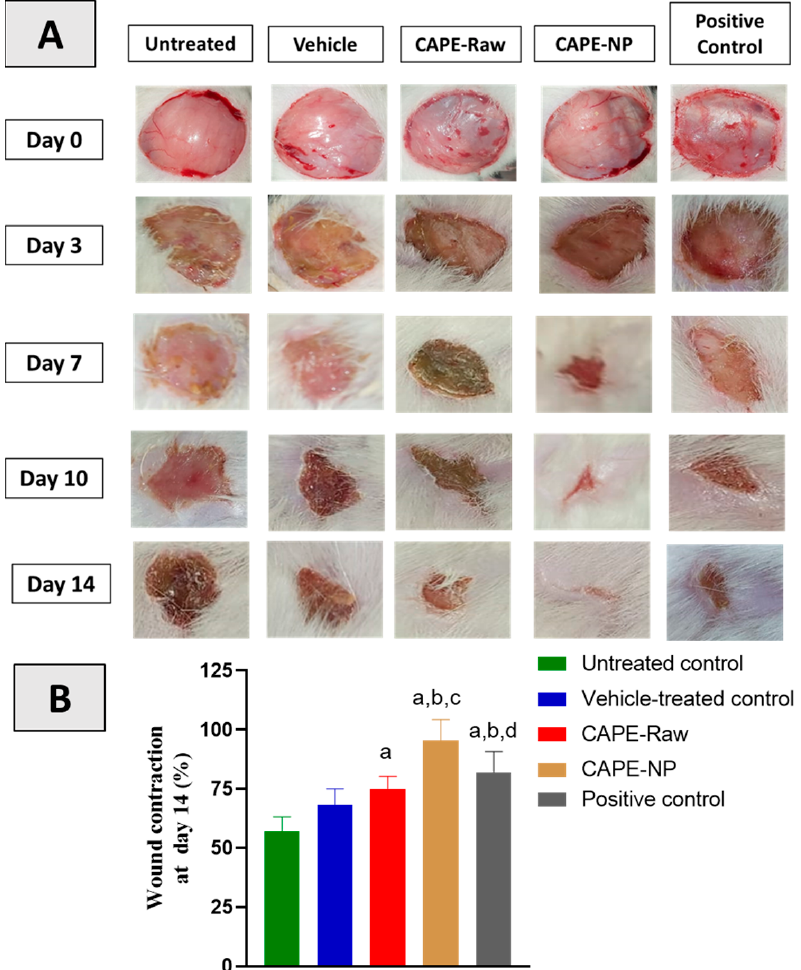
Figure 3. ( A ) Effects of CAPE-NPs on wound healing and % wound contraction on days 0,3,7,10, and 14. ( B ) Graphic presentation of wound contraction at day 14.Data are expressed as mean (n = 6) ± SD. (a) Significantly different from untreated control at p < 0.05, (b) significantly different from vehicle-treated control at p < 0.05, (c) significantly different from CAPE-raw at p < 0.05, and (d) significantly different from CAPE-NP at p < 0.05.